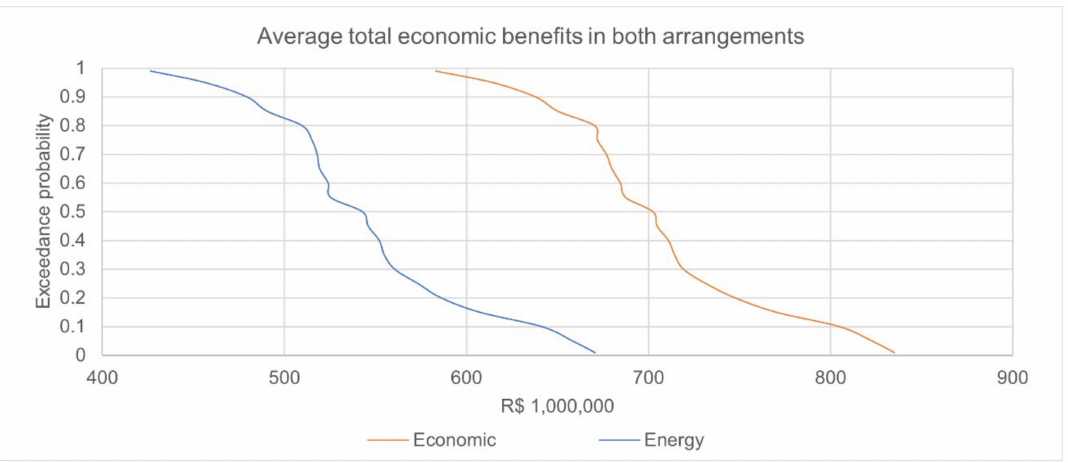
Figure 12. Exceedance curves for monthly average total benefits in the system.